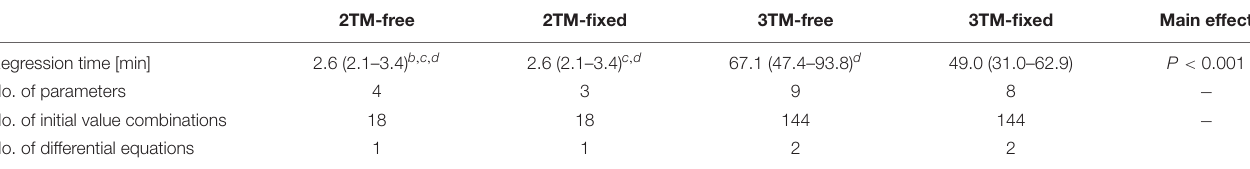
TABLE 4 | The parameter estimation solver times along with descriptive data of the four bioenergetic